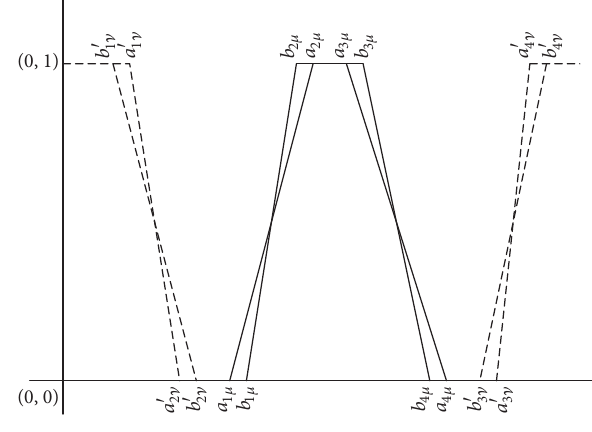
Figure 7: Pictorial representation of Example